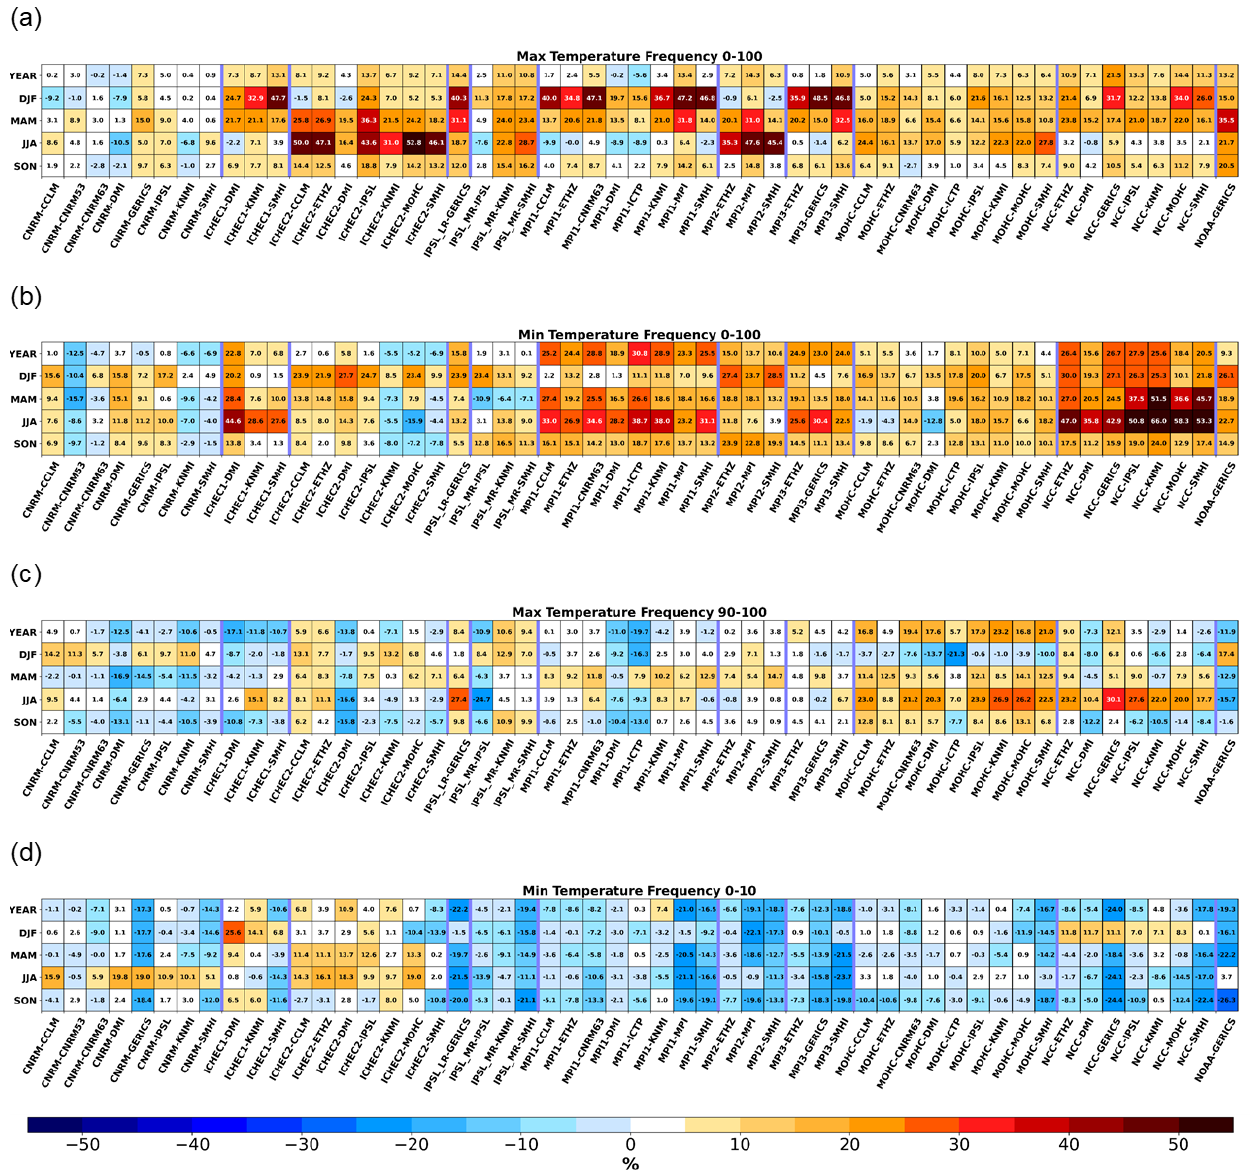
Figure 4. Yearly and seasonal distribution added values (DAVs) of the Iberian Peninsula between the RCMs and the CMIP5 GCMs for the 1989–2008 period taken from the historical EURO-CORDEX simulations, with the IGD regular dataset as a reference for (a) maximum daily temperature considering the whole PDF shown in the left panels of Fig. S3, (b) minimum daily temperature considering the whole PDF shown in the right panels of Fig. S3, (c) maximum daily temperature extremes only considering the values above the observational 90th percentile from maximum temperatures, and (d) minimum daily temperature extremes only considering the values below the observational 10th percentile from minimum temperatures. All RCM data were previously interpolated to 0.1 ◦ regular resolution from the observations, while the observations were interpolated into each CMI5 GCM resolution. The thick blue lines separate the RCMs driven by a different